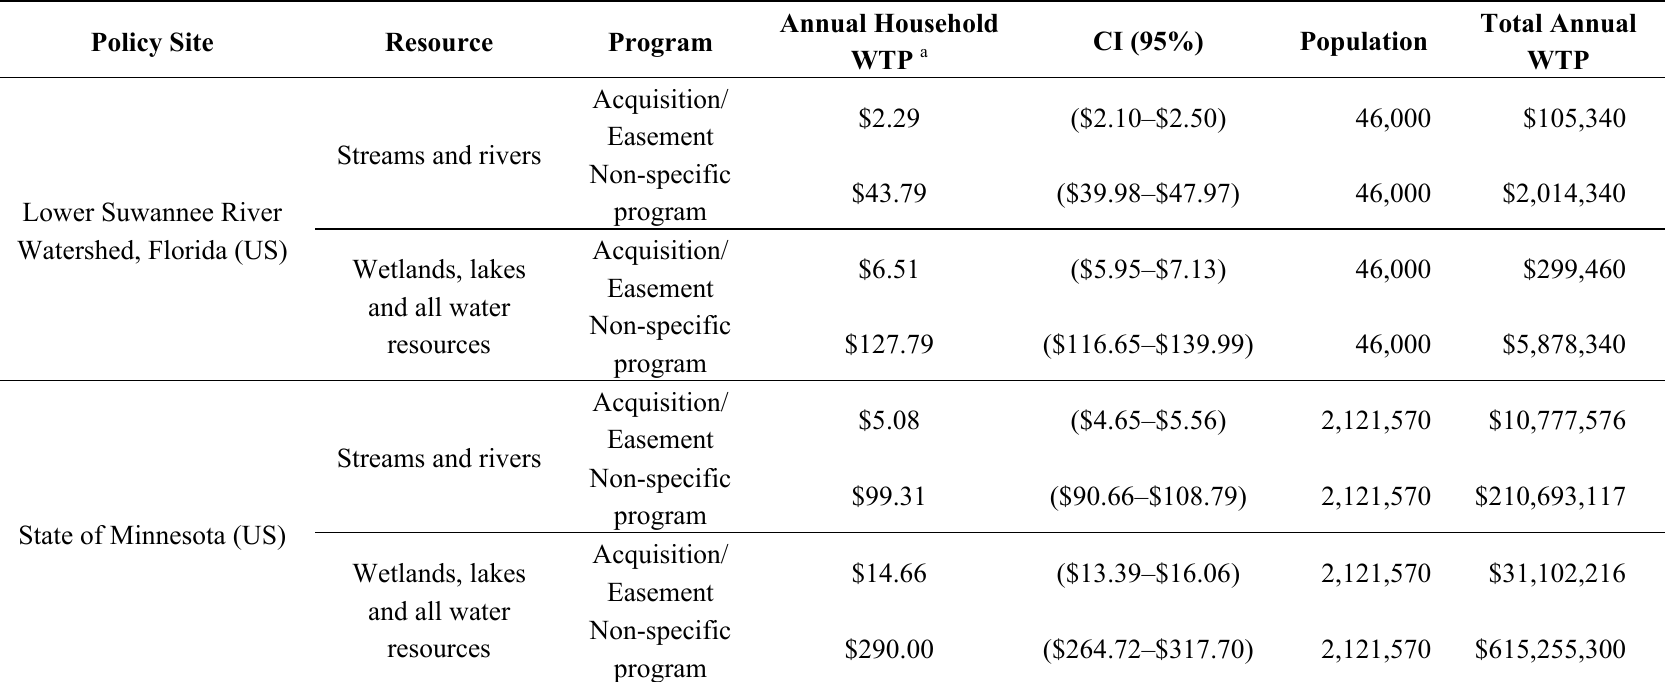
Table 4. Benefit transfer WTP for water quality protection: lower Suwannee River, Florida, and state of Minnesota